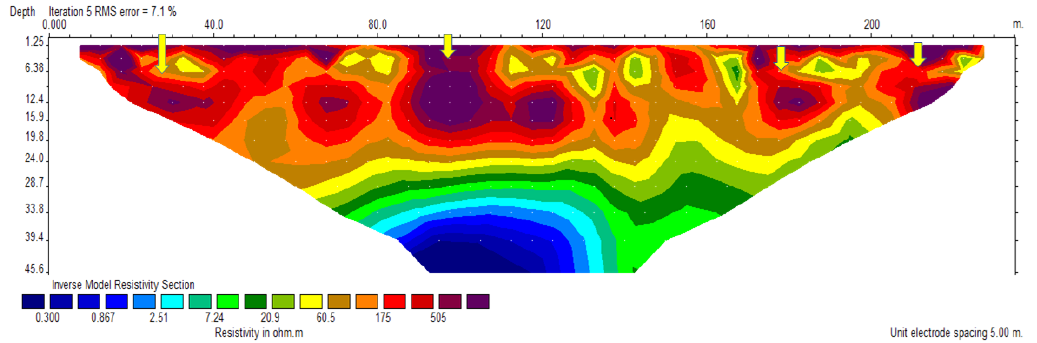
Figure 4. Resistivity image obtained from the inversion of apparent resistivity. The main cavity in the center is showing very high resistivity (second yellow arrow from the left). Other high-resistivity anomalies are noticed with the rest of the yellow arrows.